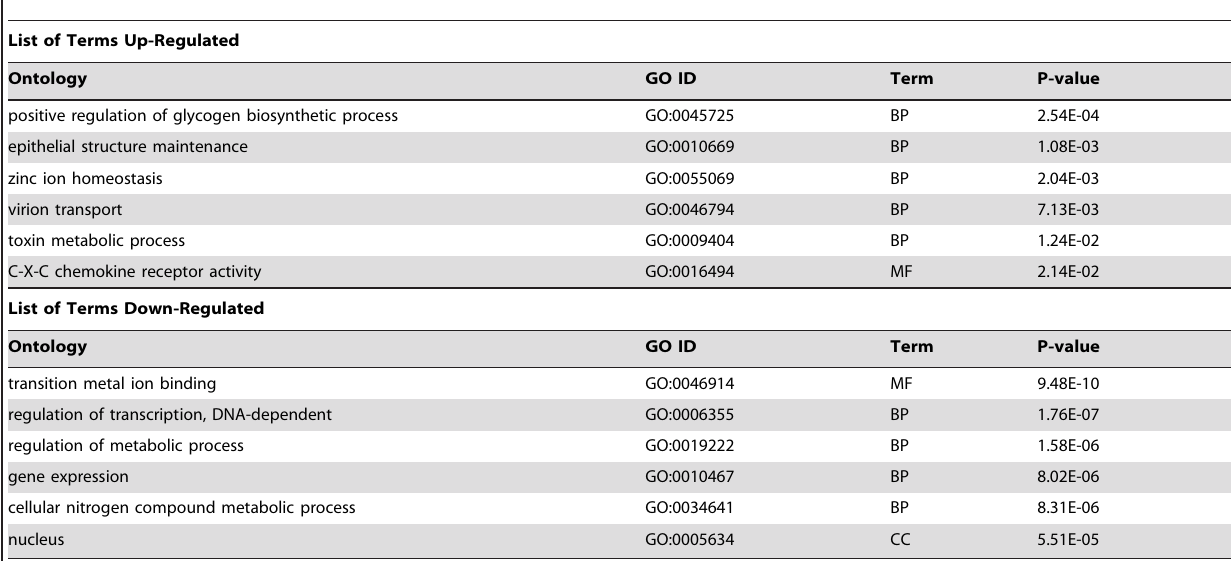
Table 1 . Over-represented human gene ontology (GO) terms determined by GOEAST